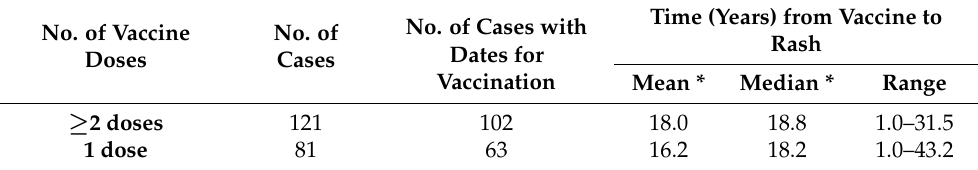
Table 2. Time (years) since last measles vaccination to rash onset date in 165 measles cases. Spain,